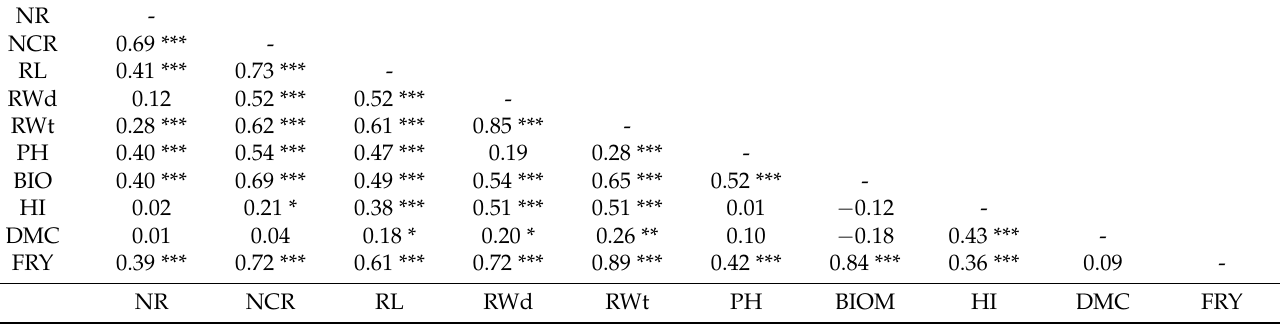
Table 4. Pearson correlation coefficients the 10 quantitative traits measured on 11 cultivars evaluated at six environments in South